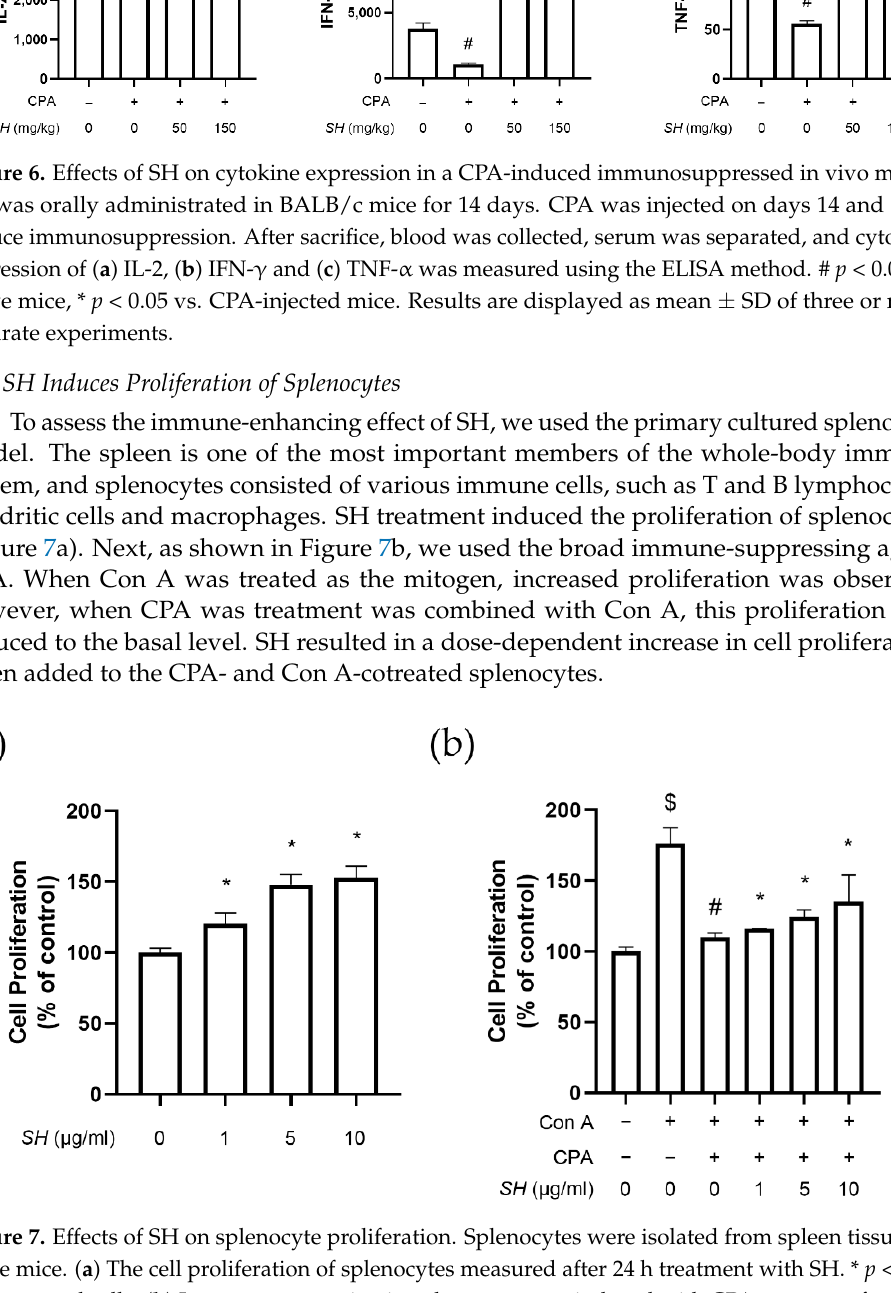
Figure 5. Effects of SH on immune functions of splenocytes isolated from CPA-induced immuno- suppressed mice. SH was orally administrated in BALB/c mice for 14 days. CPA was injected on days 14 and 16 to induce immunosuppression. After sacrifice, splenocytes were isolated, and ( a ) splenocyte numbers and proliferation in response to ( b ) Con A or ( c ) LPS were measured. ( d ) NK cells were purified from splenocytes, and YAC-1-targeting activity was measured. # p < 0.05 vs. splenocytes from naïve mice, * p < 0.05 vs. splenocytes from CPA-injected mice. Results are displayed as mean ± SD of three or more separate experiments.